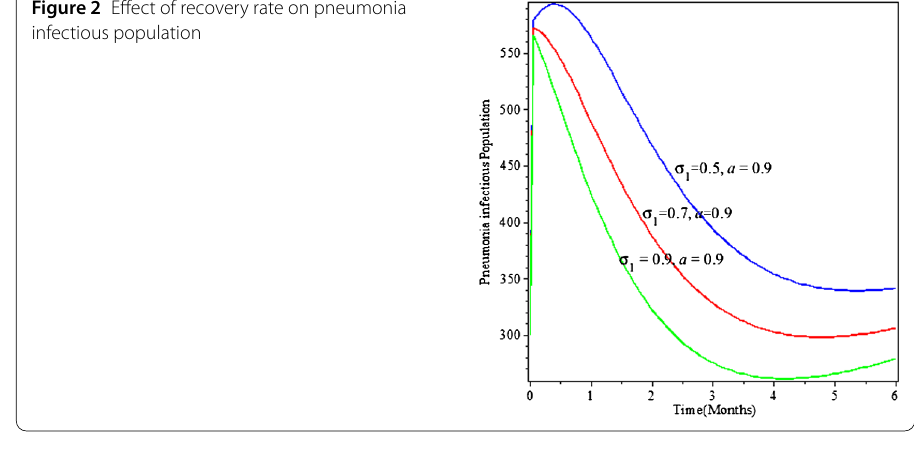
Figure 3 Effect of recovery rate on meningitis infectious